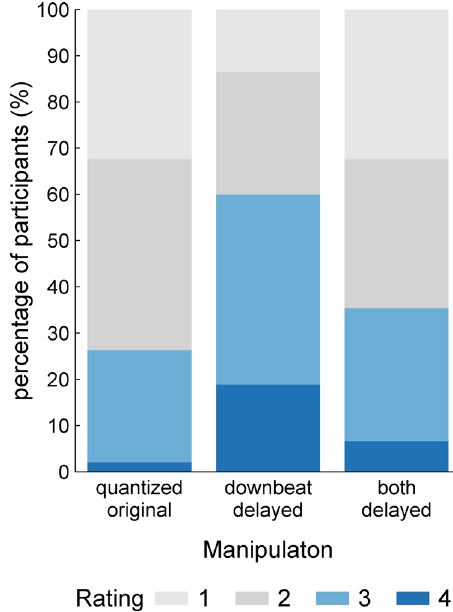
Fig. 4 Distribution of swing ratings given by professional and semiprofessional jazz musicians to different manipulated versions. The three stacked histograms display the proportions of different possible ratings from 1 ( “ not at all ” ) to 4 ( “ very much ” ) averaged over three pieces. The downbeat delayed manipulation in the center elicits a much larger portion of high ratings (3 and 4 in blue colors) than the two other manipulations.